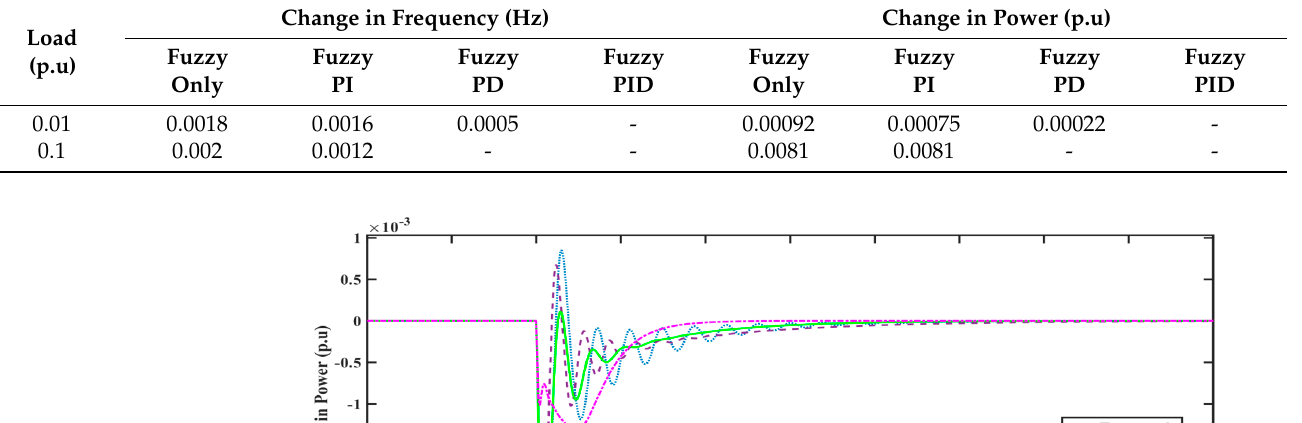
Table 4. The amplitude of oscillations in frequency and power of hybrid system for Fuzzy, Fuzzy-‘PI’, Fuzzy-‘PD’ and Fuzzy-‘PID’ against different loads.